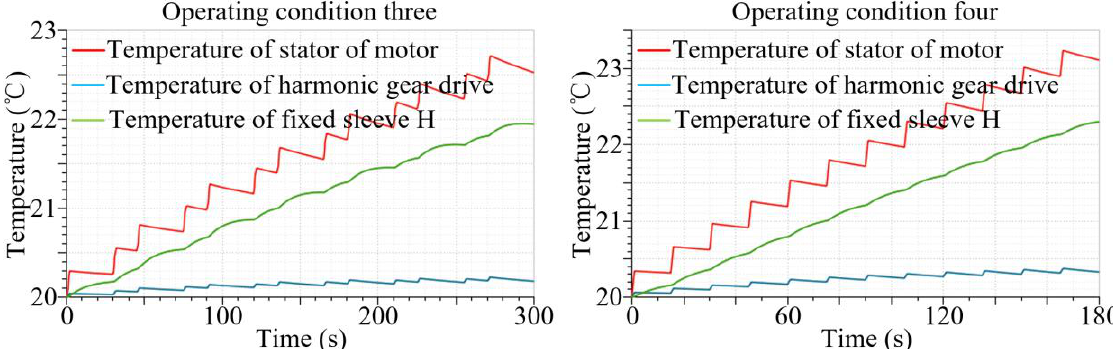
Figure 15. Variation of temperature of parts and components over time.